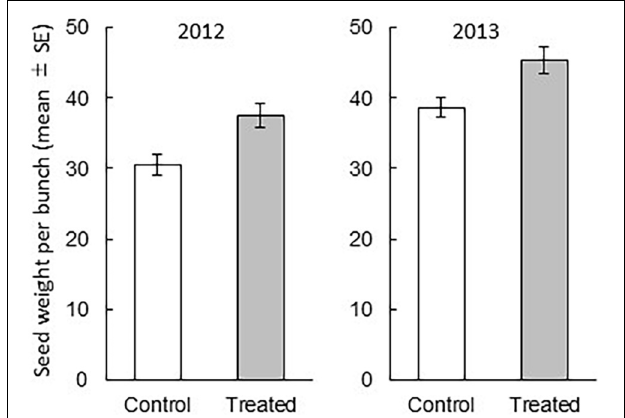
FIGURE 2 | Comparison between the rice grain weight (mean ± SE) from a treated bunch and that from a control bunch (treatment P = 0.0073, year P < 0.0001, treatment × year P = 0.9126). The effects of treatment, year, and their interaction on grain weight per bunch were analyzed with the least square mixed model after Box-Cox transformation. N = 15, except for the data of one field in 2013 ( N =